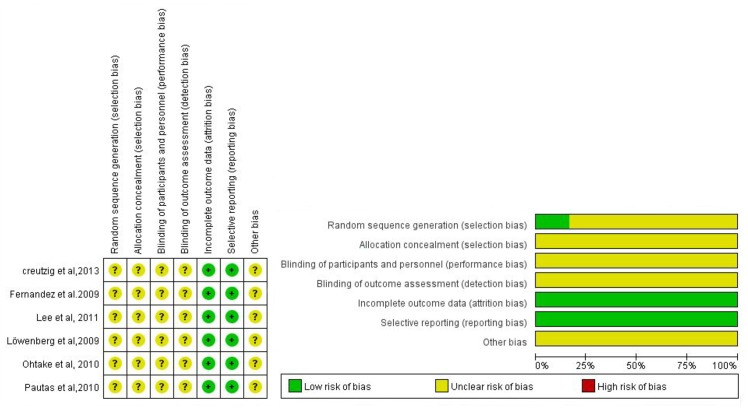
Risk of bias.This figure was the summery for risk of bias within six studies. It was formed using Revman 5.2. The definition of sources of bias and methods of assessing risk of bias can be found in Cochrane Handbook for Systematic Reviews of Interventions.